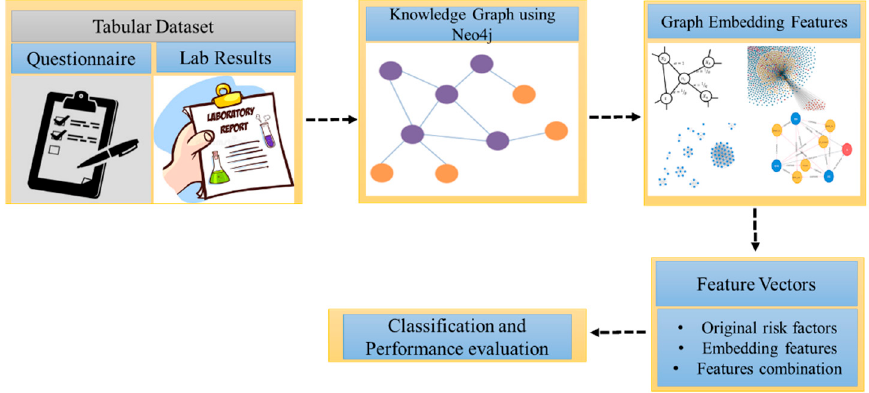
Figure 1. Proposed methodology.